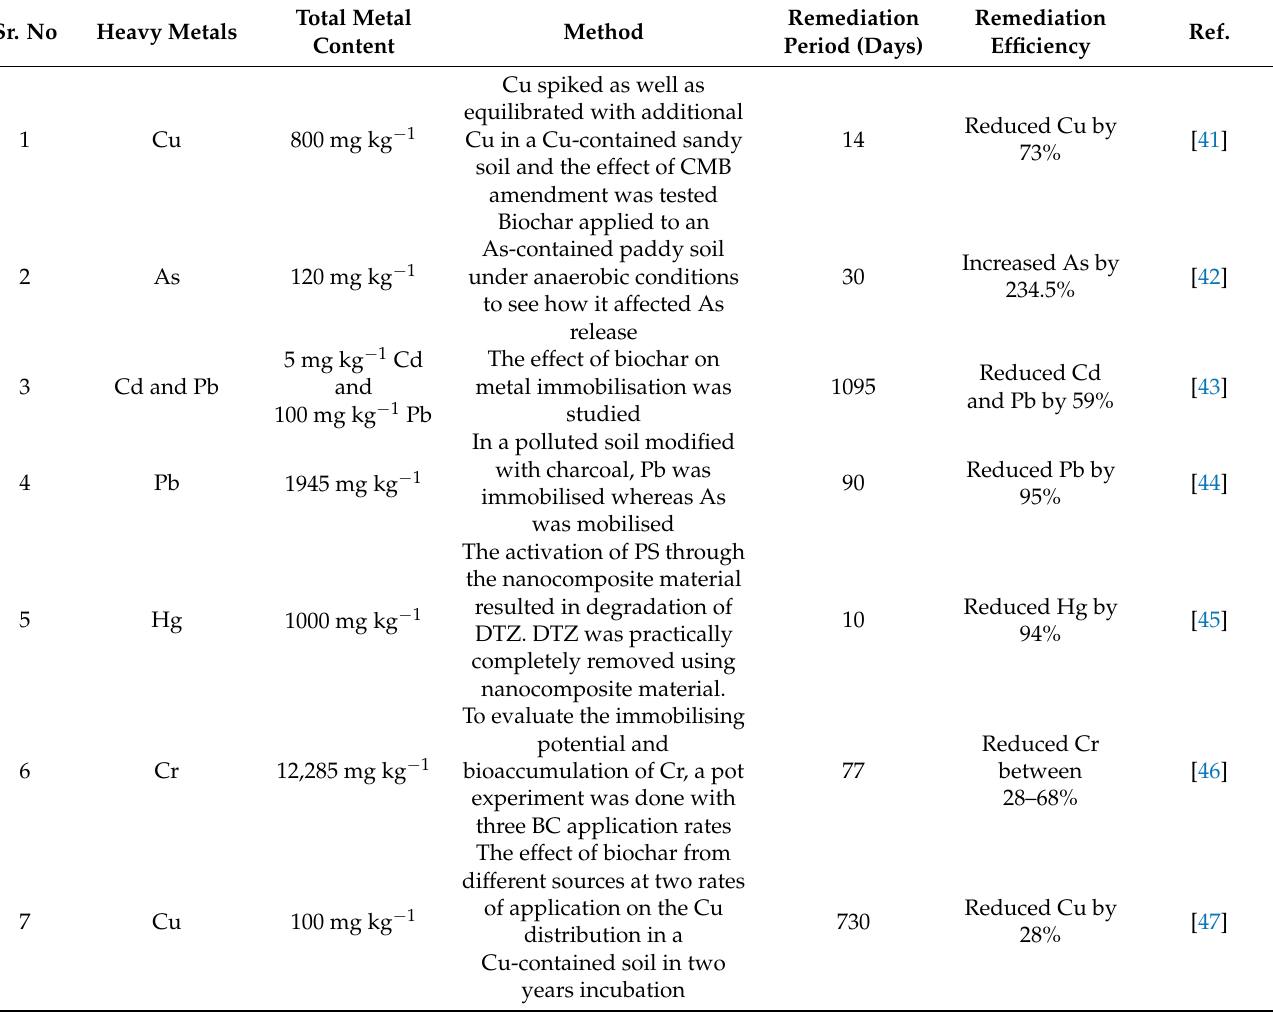
Table 2. Remediation period and efficiency of heavy metals in